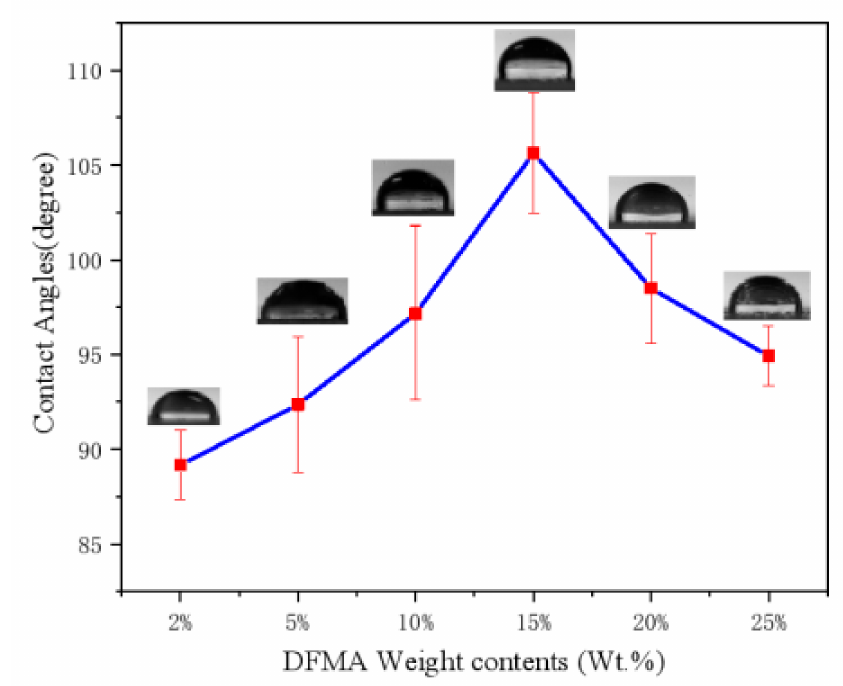
Figure 8. Influence curves of TVi 7iso -POSS amount on the contact angle of the